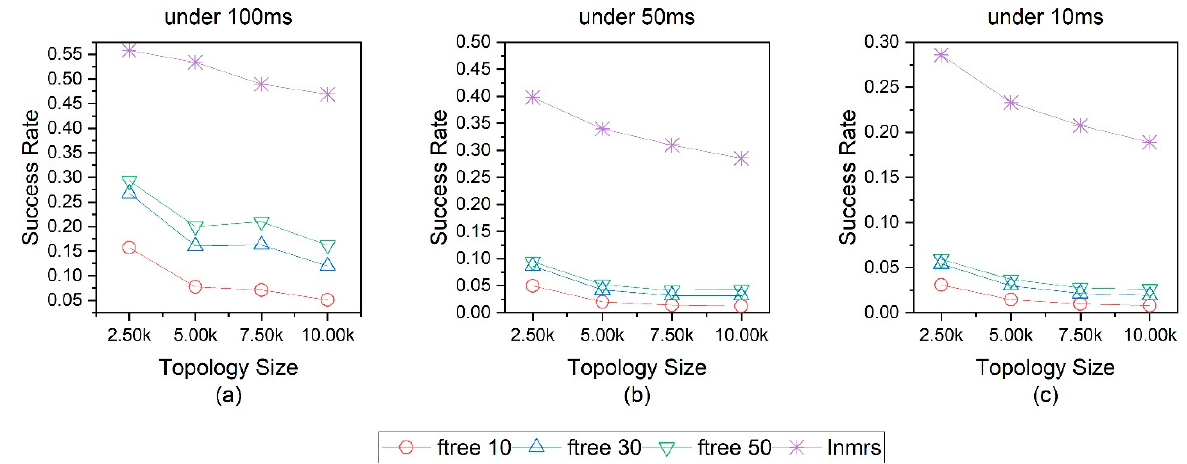
Figure 17. Success resolution rate under different time limits.